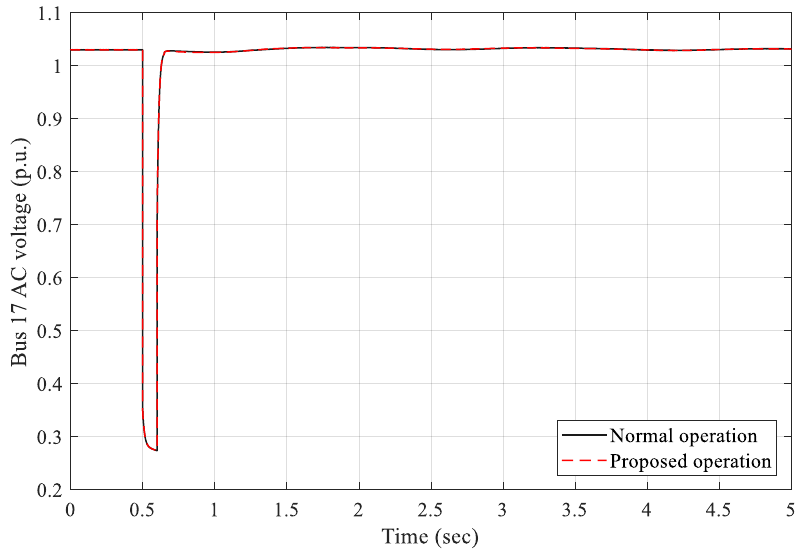
Figure 18. The AC voltage of the inverter station for the load side event.